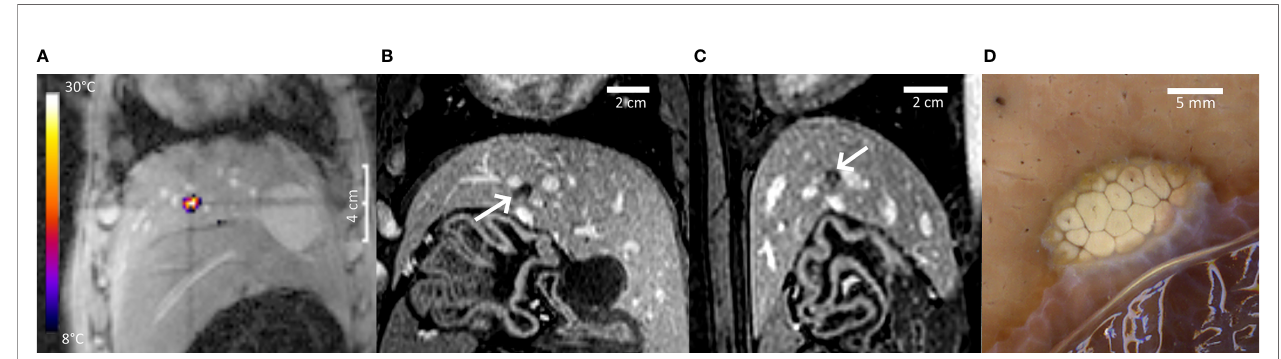
FIGURE 7 | Highlights of pig #2 experiment. (A) PRFS MR temperature map merged with the magnitude image at the end point of a 40-s HIFU sonication, coronal plane. A color bar of temperature elevation is provided. (B, C) Non-perfused volume on Gd-enhanced MRI, coronal and sagittal. (D) Post-mortem gross pathology of the lesion after formalin fi xation, con fi rming the well-de fi ned thermal ablation. A distance scale is embedded in